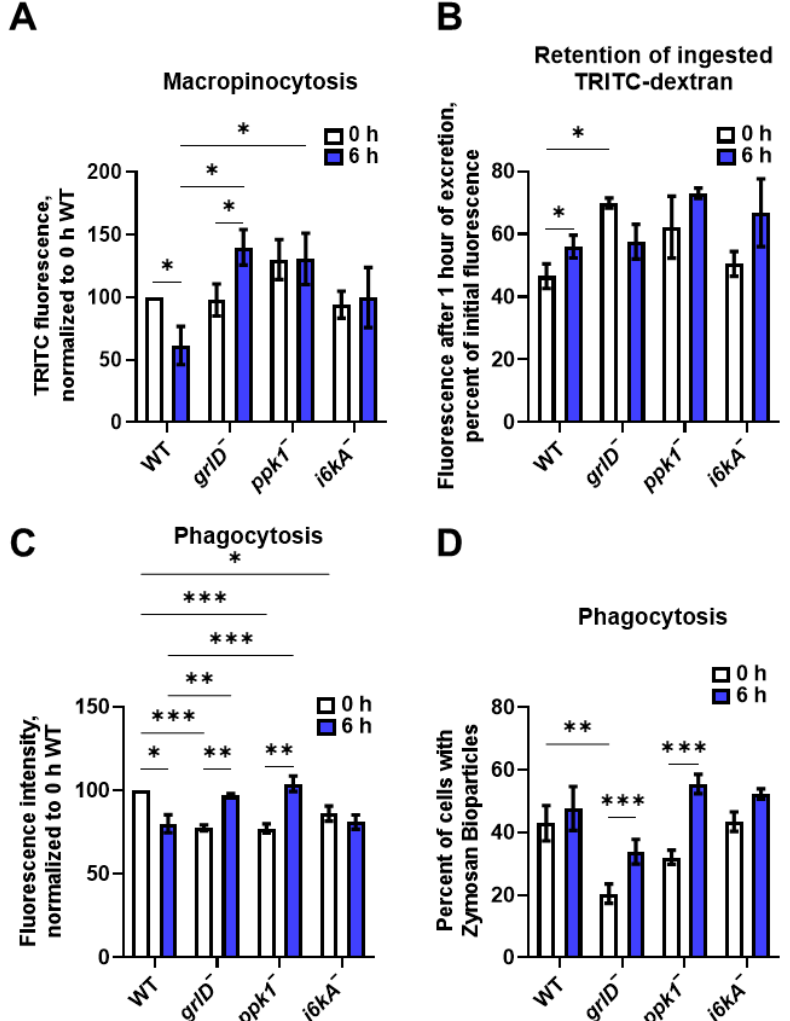
Figure 4. Starving D. discoideum cells require GrlD, Ppk1, and I6kA to reduce macropinocytosis, exocytosis, and phagocytosis. ( A ) WT, grlD − , ppk1 − , and i6kA − cells starved in PBM for 0 or 6 h were allowed to macropinocytose TRITC ‐ dextran, and the median fluorescence intensity per cell of ingested TRITC ‐ dextran were measured. The median fluorescence intensity per cell in WT cells starved for 0 h was considered 100%. ( B ) WT, grlD − , ppk1 − , and i6kA − cells starved in PBM for 0 or 6 h were allowed to macropinocytose TRITC ‐ dextran as in ( A ), uningested TRITC ‐ dextran was removed, and cells were allowed to excrete the ingested TRITC ‐ dextran for 1 h. The median fluorescence intensities per cell of TRITC ‐ dextran retained after 1 h of excretion were determined. ( C , D ) WT, grlD − , ppk1 − , and i6kA − cells were starved for 0 or 6 h and allowed to phagocytose Zymosan ‐ A bioparticles for 1 h. The average median fluorescence intensity of ingested bioparticles, normalized to 0 h WT cells are shown in ( C ), and percentages of cells with ingested bioparticles are shown in ( D ). For all panels, cells were starved in stationary submerged culture. All values are mean ± SEM of 4 independent experiments. * indicates p < 0.05, ** p < 0.01, *** p < 0.001 (Two ‐ way ANOVA with Šídák’s multiple comparisons test).